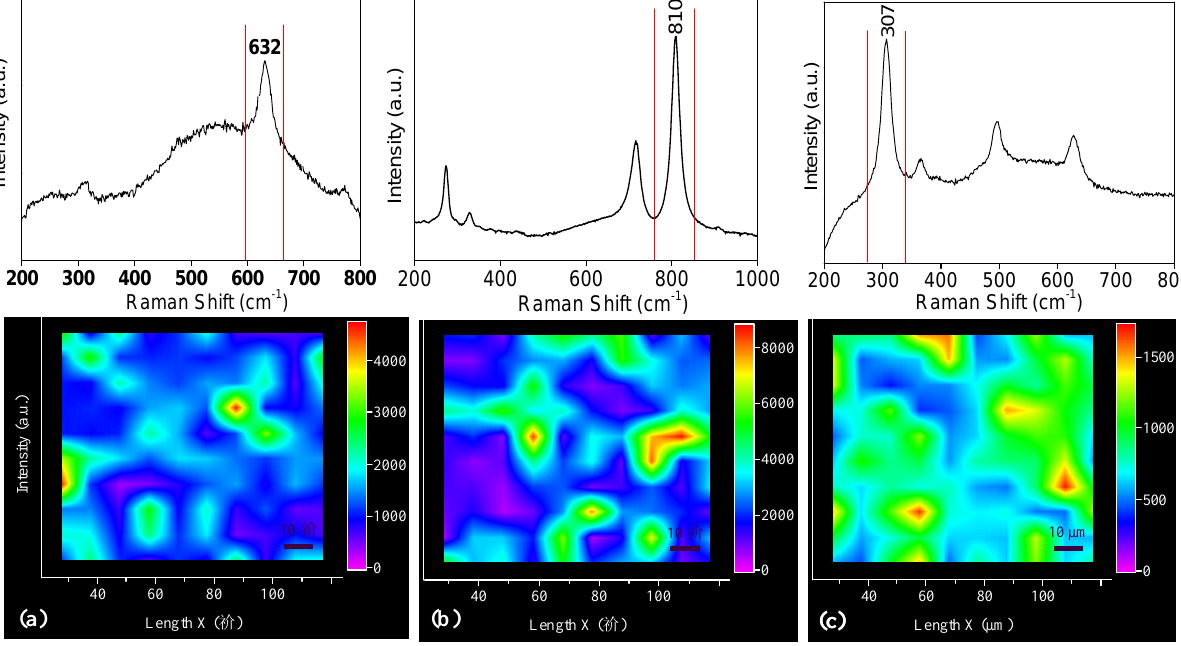
Figure 4. Raman spectra and cartographies of (a) Cu-SnO